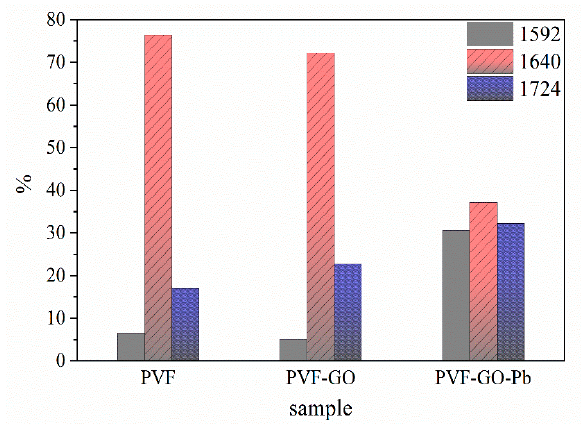
Figure 5. Area under the peaks from 1500 to 1800 cm − 1 for the PVF, PVF/GO and PVF/GO/Pb composite.